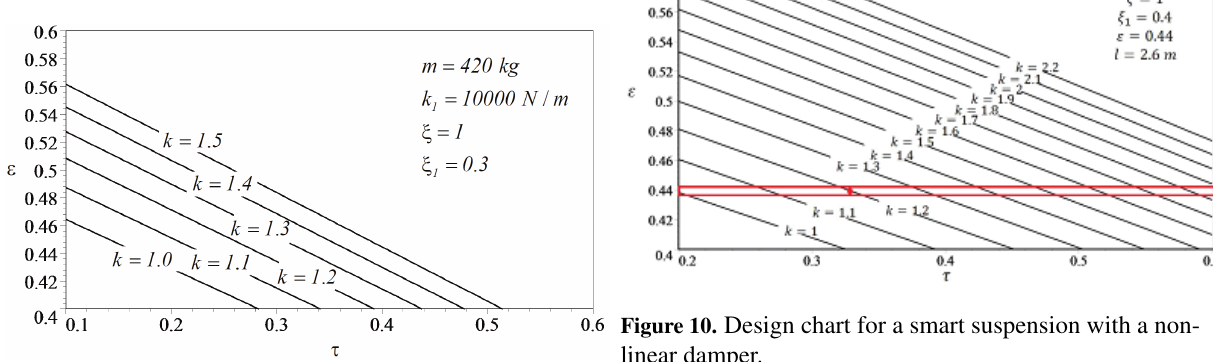
Figure 7. " versus (cid:28) , for different k for (cid:24) 1 D 0:3 to have near flat ride with ideal nonlinear damping.